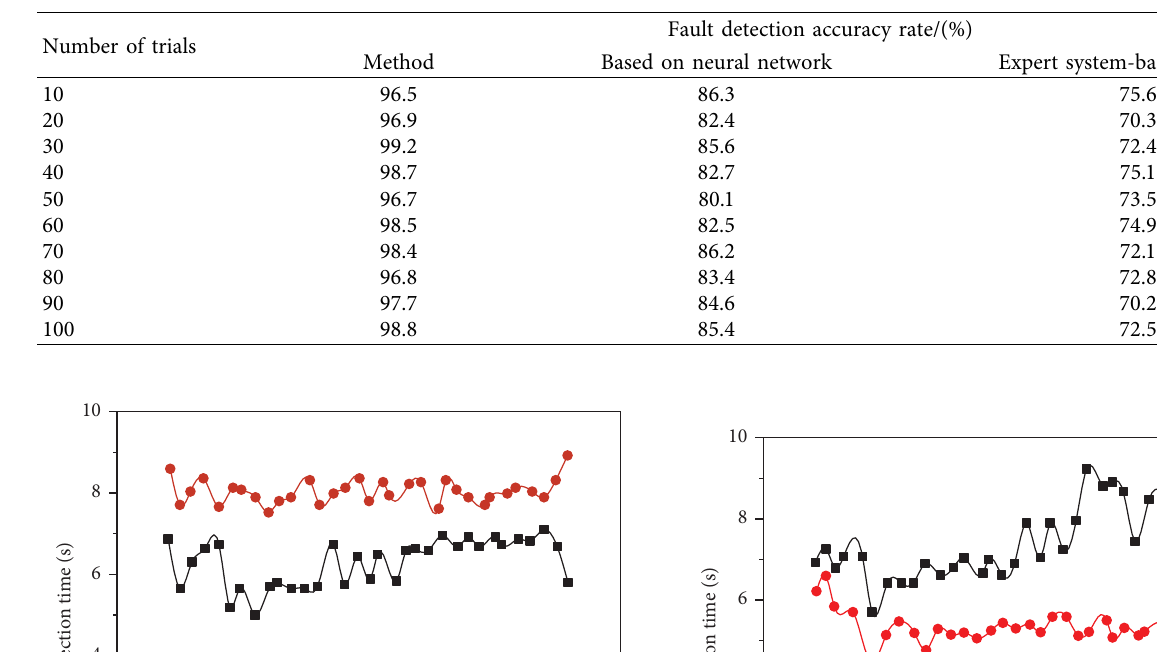
Table 2: Comparison of fault diagnosis accuracy.